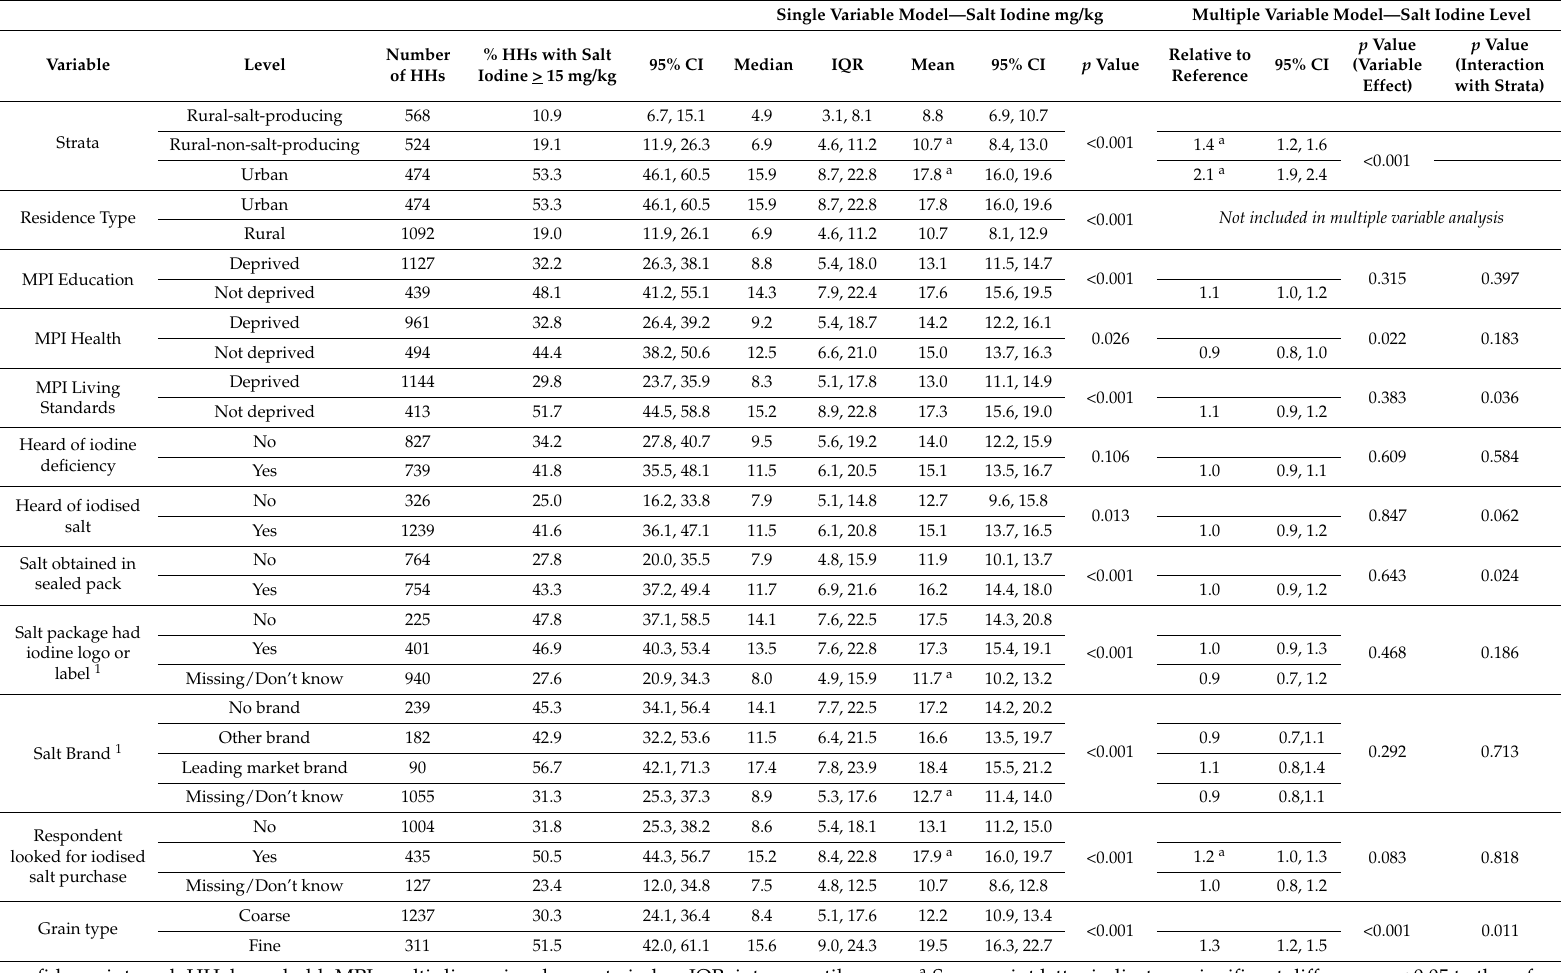
Table 5. Regression analyses of factors associated with household salt iodine